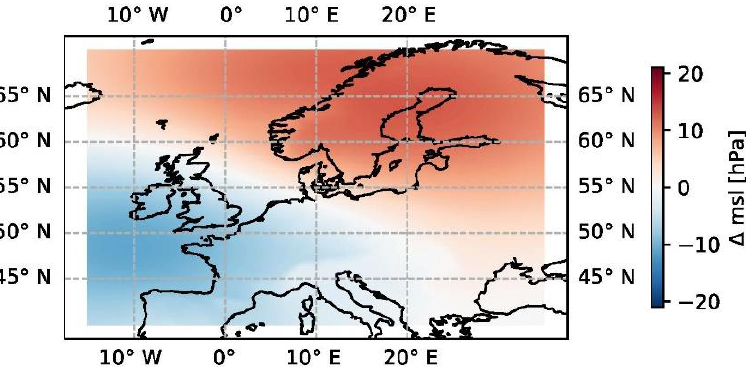
Figure 8. See Figure 7, but for days with SE weather type derived from 1950–2019 ERA5 reanalysis.